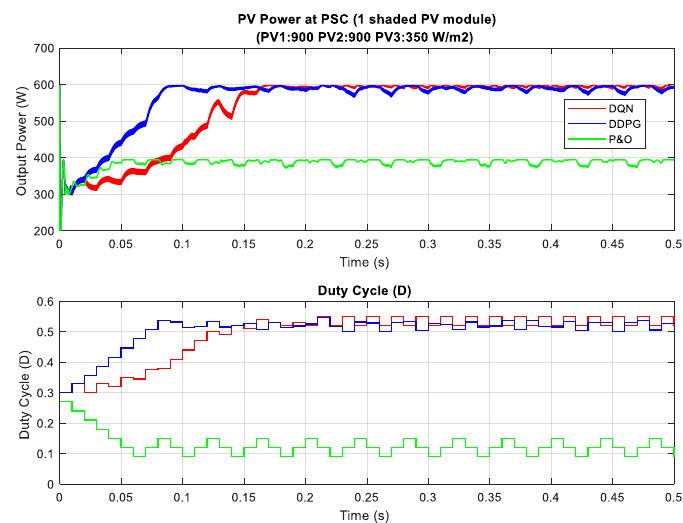
Figure 14. PV power under partial shading condition (PSC) with one shaded PV module.